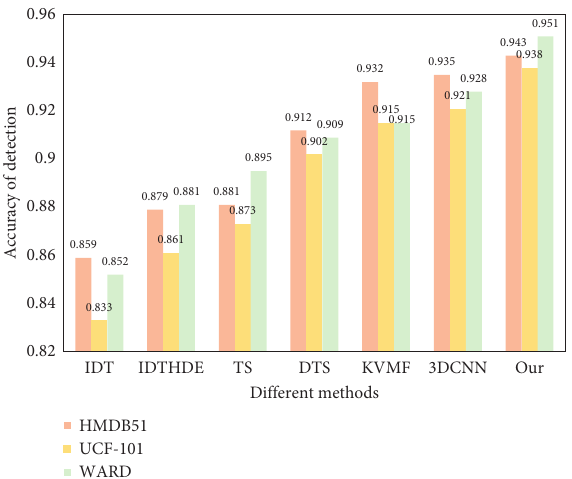
Figure 10: Comparison of recognition accuracy of different